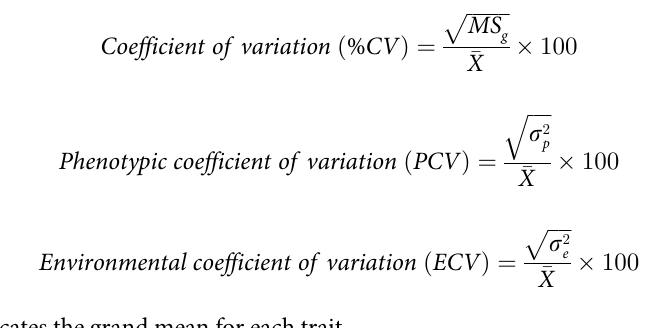
S1 Table. Descriptive statistics and analysis of variance for six traits evaluated across three